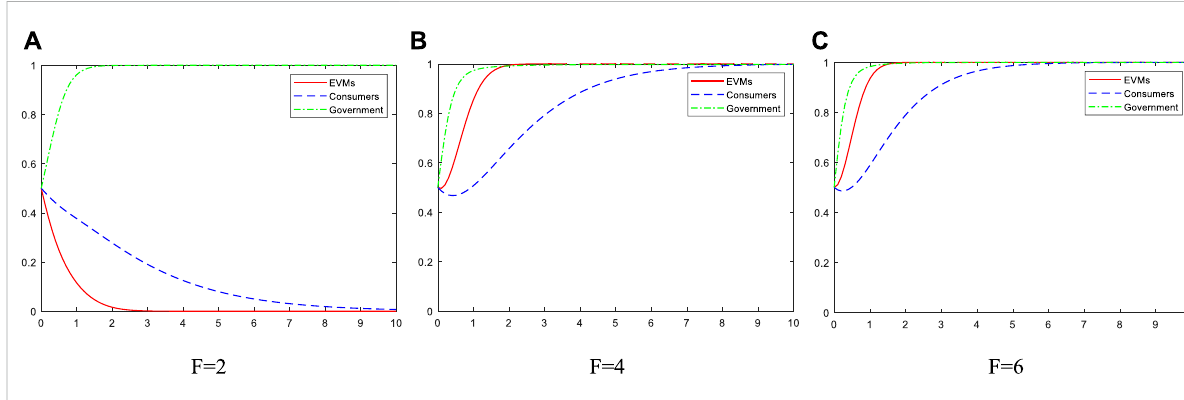
FIGURE 4 Impact of different values of penalty on the evolutionary process.